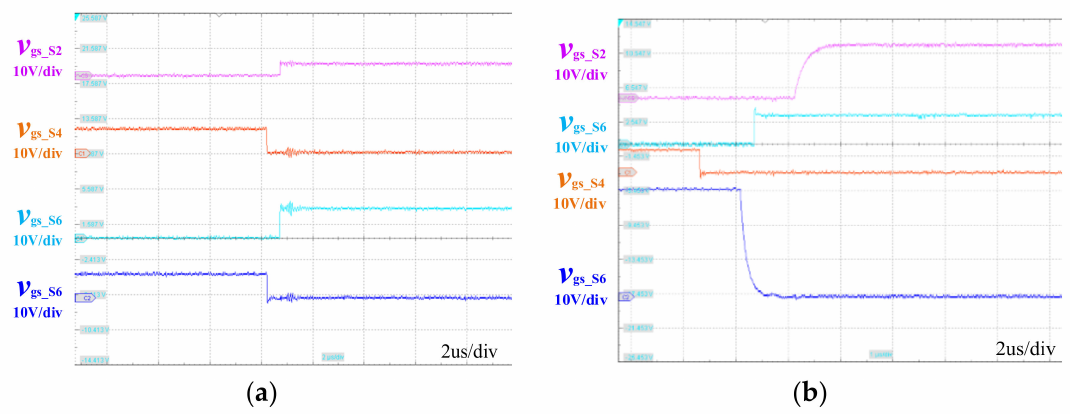
Figure 18. ( a ) Traditional and ( b ) modified modulation strategy.